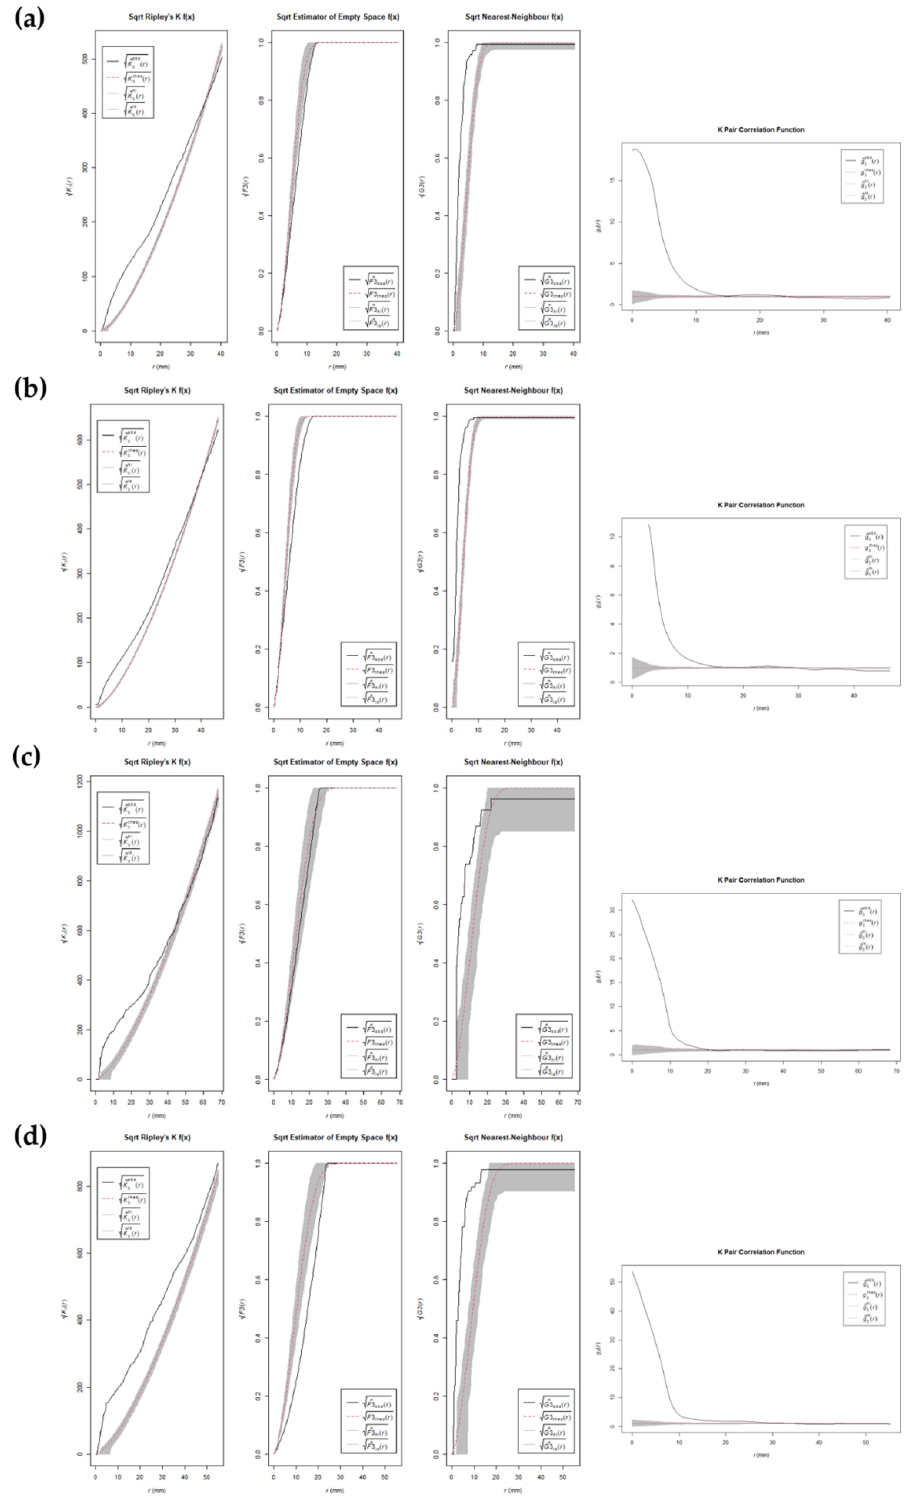
Figure 4. Plots of the square root version of the K-function, F empty space function, G near-neighbor function, and pair-correlation function for ( a ) tooth marks on right femora generated by captive wolves; ( b ) tooth marks on left femora generated by captive wolves; ( c ) tooth marks on right femora generated by wild wolves; ( d ) tooth marks on left femora generated by wild wolves. Dotted red line shows the Poisson complete spatial random (CSR) process, the black line shows the empirical point process of the target sample, and the gray band shows simulated confidence intervals.